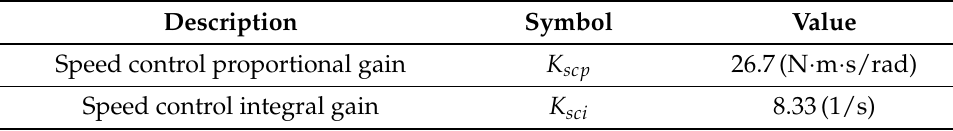
Table A2. Parameters for Speed Control.